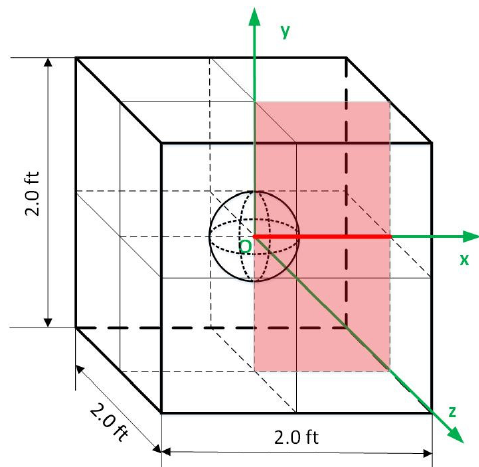
Figure 16. ICs of Case 3.